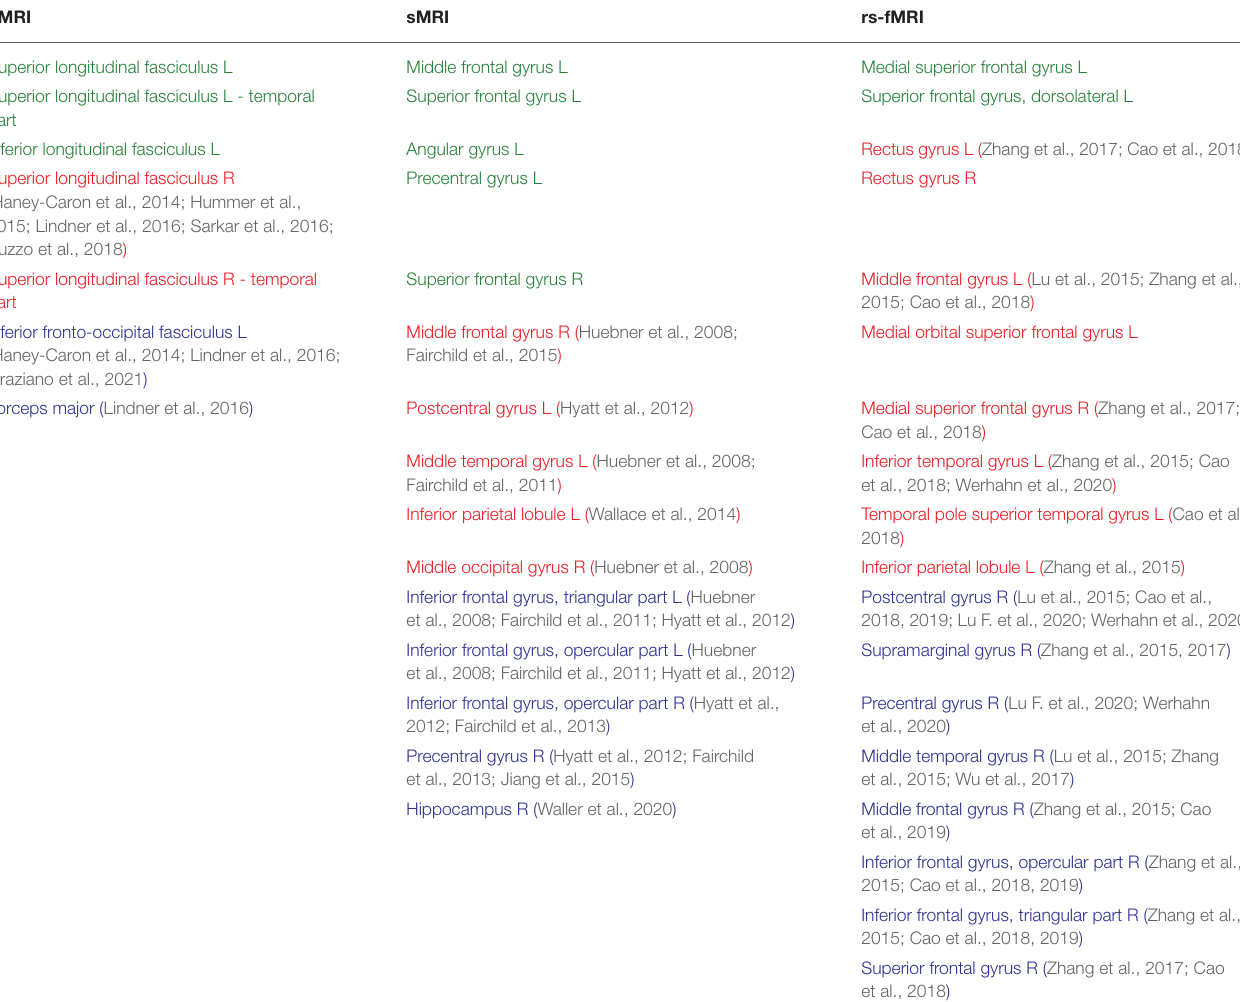
TABLE 3 | Brain regions primarily contributing to children